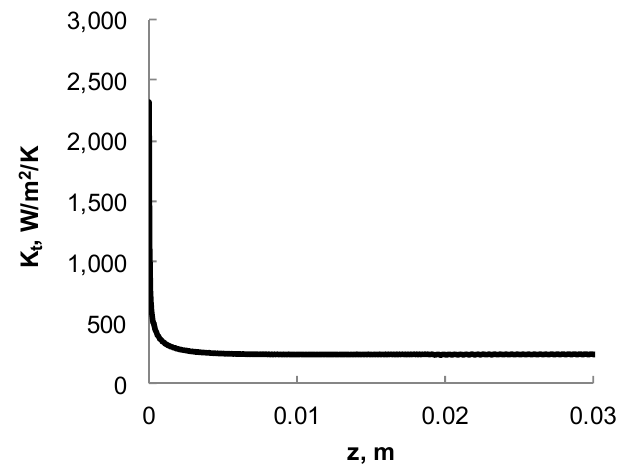
ffi cient along the monolith cell